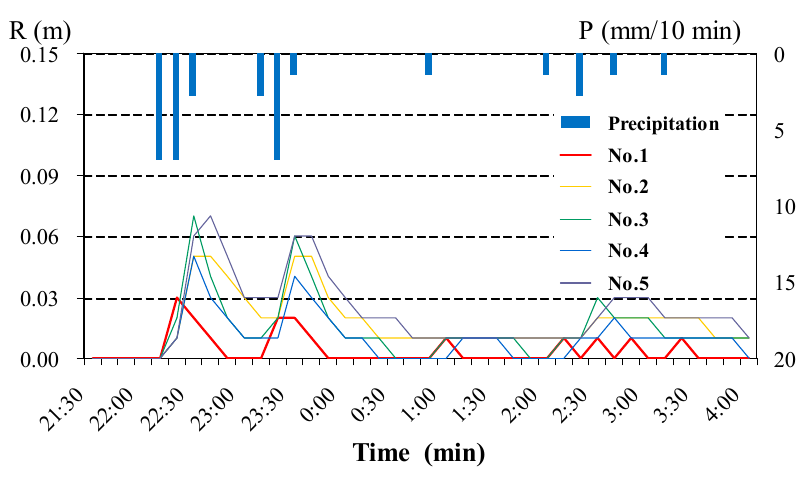
Figure 7. Simulated “9.07” runoff processes at different positions.